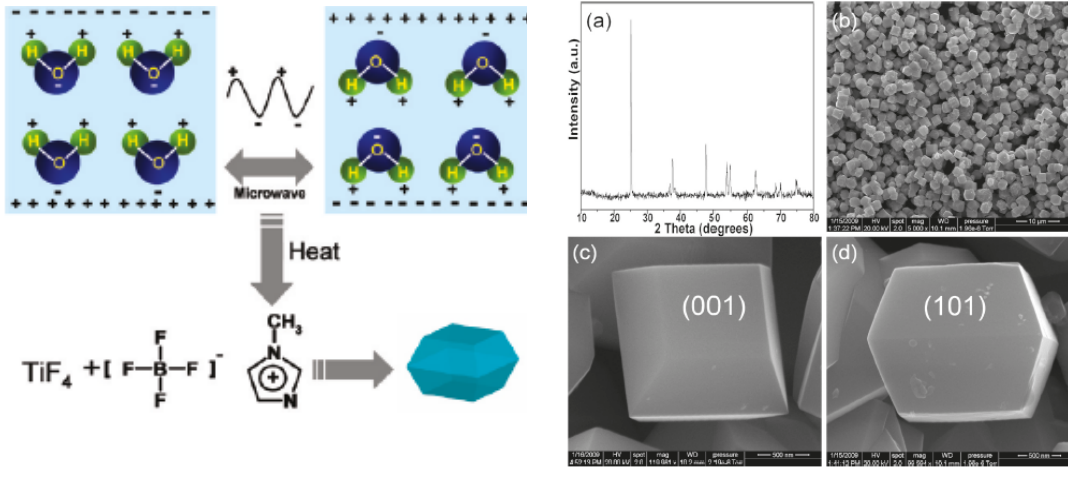
Figure 5. Scheme of formation mechanism of {001} facets exposed TiO irradiation. ( a ) Typical XRD pattern; ( b ) Low-magnification FESEM image, and side view FESEM image of TiO samples prepared with ( c ) 30 mL of 0.04 M TiF 2 ionic liquid at 210 °C for 90 min. Reprinted with permission from ref. [42]. Copyright 2010 American Chemical